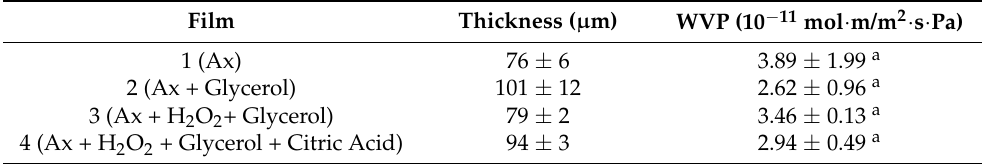
Table 5. Water vapor permeability (WVP) (10 − 11 mol · m/m 2 · s · Pa) and thickness ( µ m) of arabinoxylan films tested. Values in the same column followed by different superscript letters differ significantly ( p <